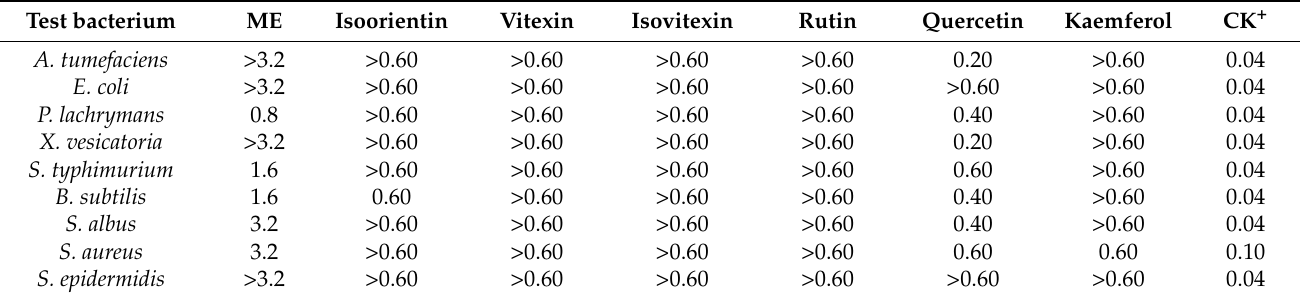
Table 2. The MIC values of crude methanol extract of Tartary buckwheat sprouts and six major flavonoids against test